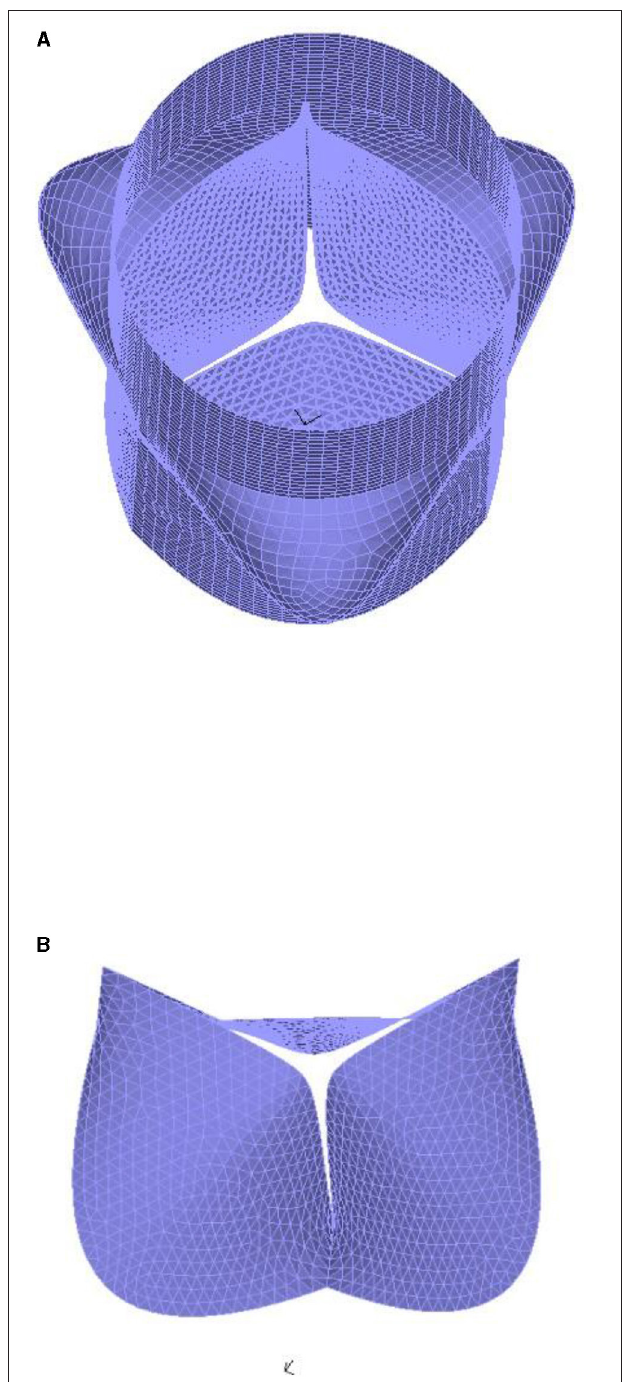
FIGURE 3 | The mesh of the aortic root. (A) the whole model; (B) the leaflets.